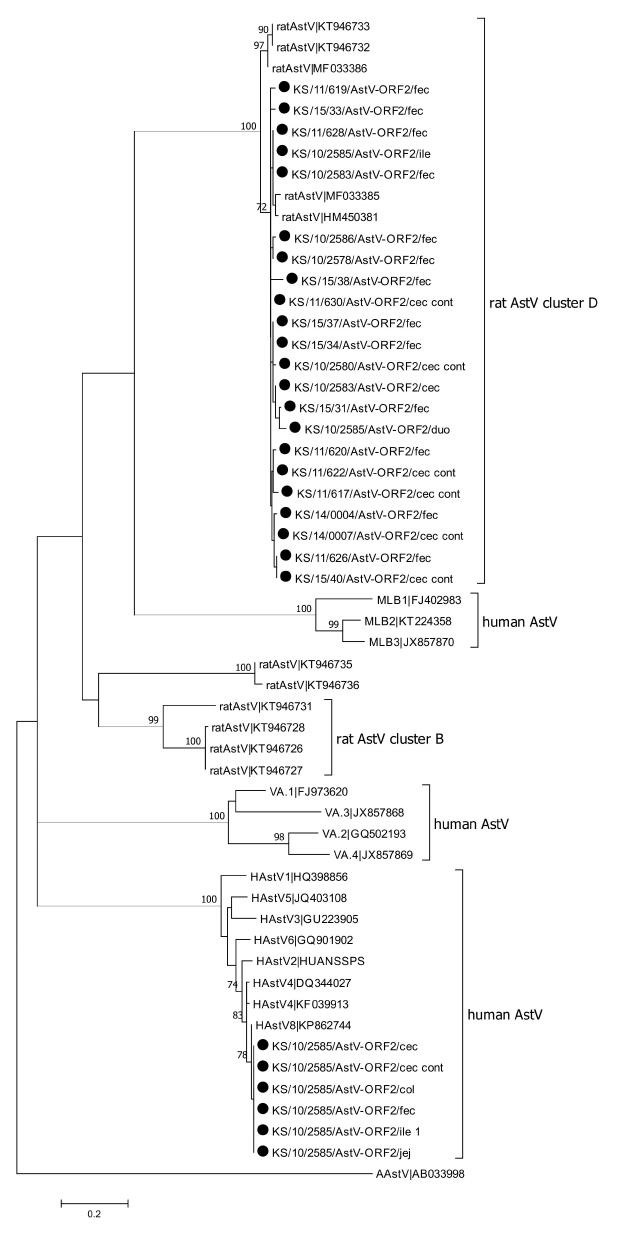
Figure 1. Phylogenetic tree of a 970 nucleotide (nt) alignment of the ORF1/ORF2 junction region of the novel astrovirus (AstV) strains detected in animals of this study (denoted by dot) and AstV reference sequences (accession numbers are indicated). The tree was reconstructed using the Maximum Likelihood method based on the Kimura 2-parameter model with Bootstrap test (1000 replicates). Bootstrap values above 70 are shown. The bar indicates the number of substitutions per site. An avian astrovirus sequence (AAstV|AB033998) was used as outgroup. Abbreviations: cec = cecum; cont = content; col = colon; duo = duodenum; fec = feces; ile = ileum; jej =